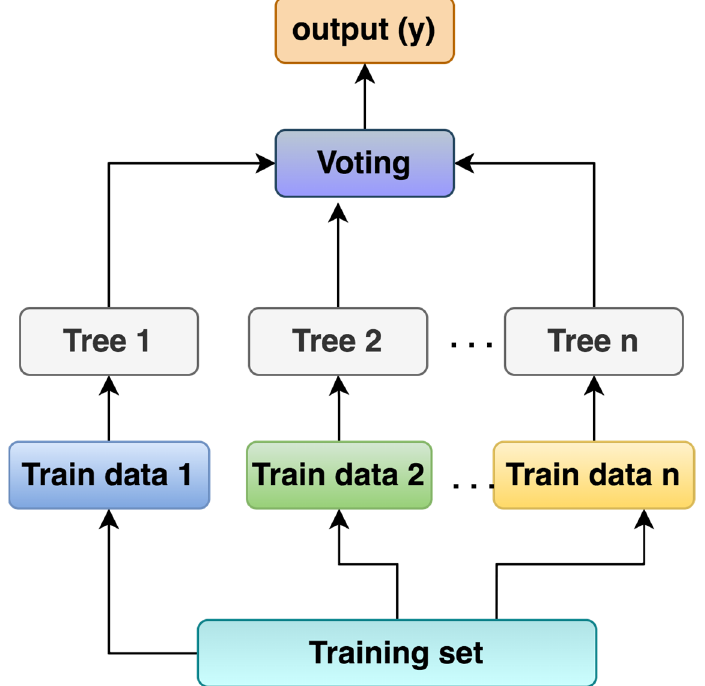
Figure 4. Random forest working principal illustration.